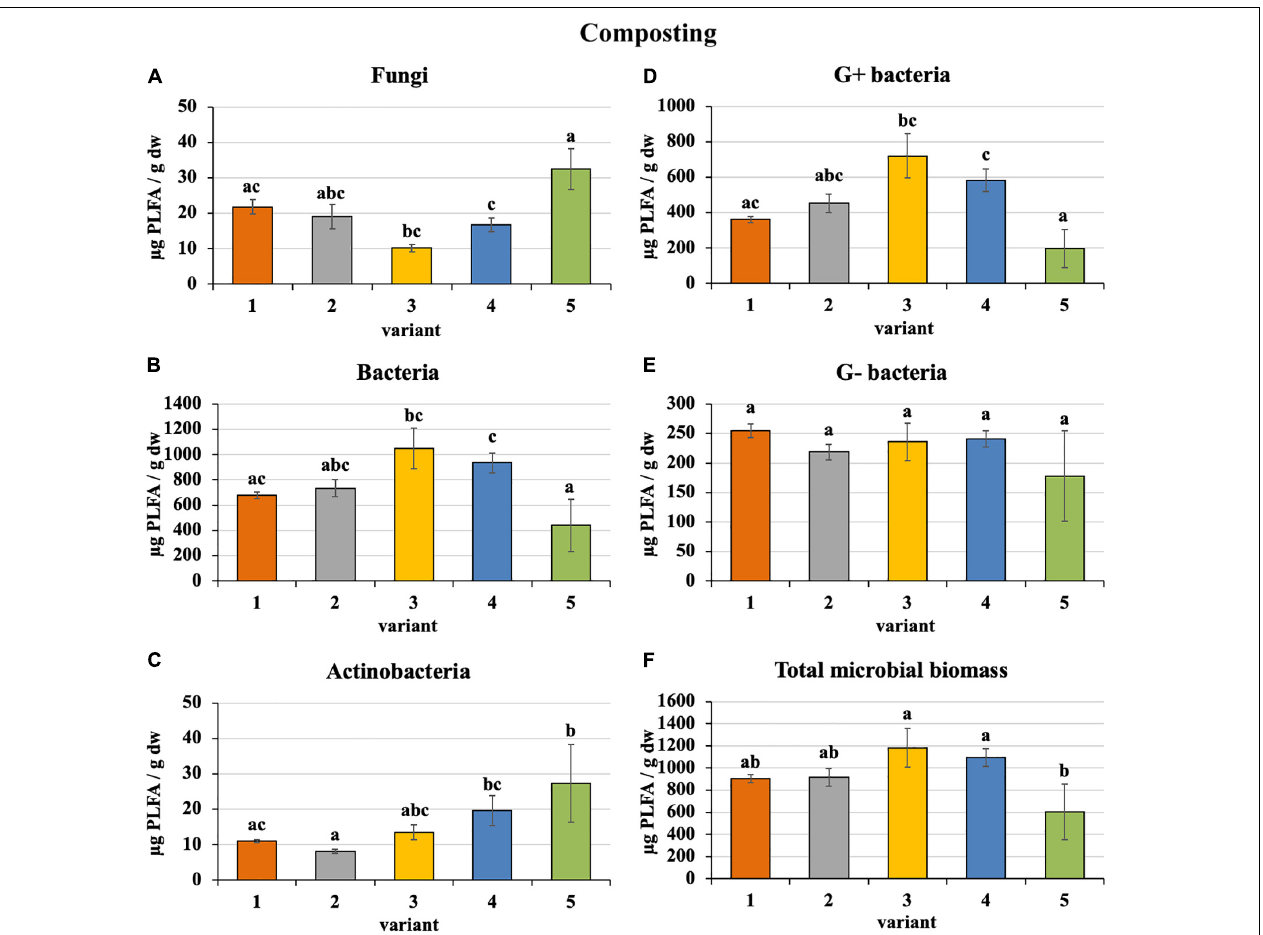
FIGURE 2 | Content of microorganisms after composting feedstock. Treatments: (1) sludge 100%, (2) sludge 75% + PWS 25%, (3) sludge 50% + PWS 50%, (4) sludge 25% + PWS 75%, and (5) PWS 100%. Values are means ± SD ( n = 3). Different letters indicate significant differences among treatments (Kruskal–Wallis test, P ≤ 0.05). PWS, pelletized wheat straw; PLFA, phospholipid fatty acids; dw, dry